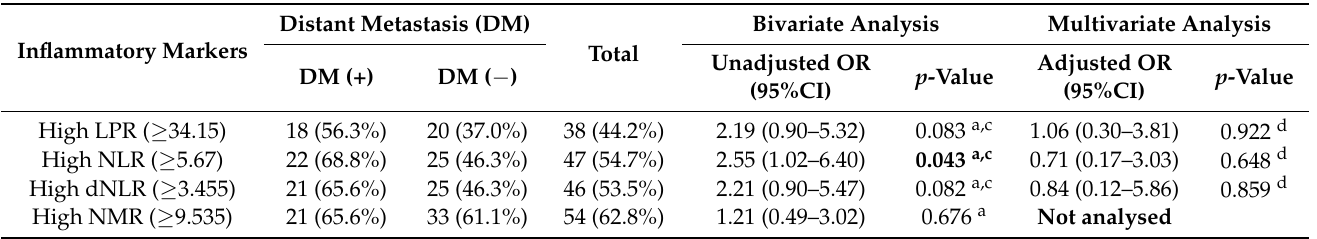
Figure 3. Three ROC analysis curves employed to assess the ability of significant inflammatory markers in modelling three clinical endpoints of vulvar cancer: ( A ) performance evaluation for a model that includes factors associated with advanced-stage vulvar cancer; ( B ) performance assessment for a model that takes into account factors related to the incidence of lymph node metastases in vulvar cancer patients; and ( C ) performance estimation for a model that include factors related to the incidence of distant metastases in vulvar cancer patients. Abbreviation: AUC: area under the curve; CI: confidence interval; ROC, receiver operating characteristic curve. Table 7. Performance of inflammatory markers using their tailored cut-offs associated with dis- tant